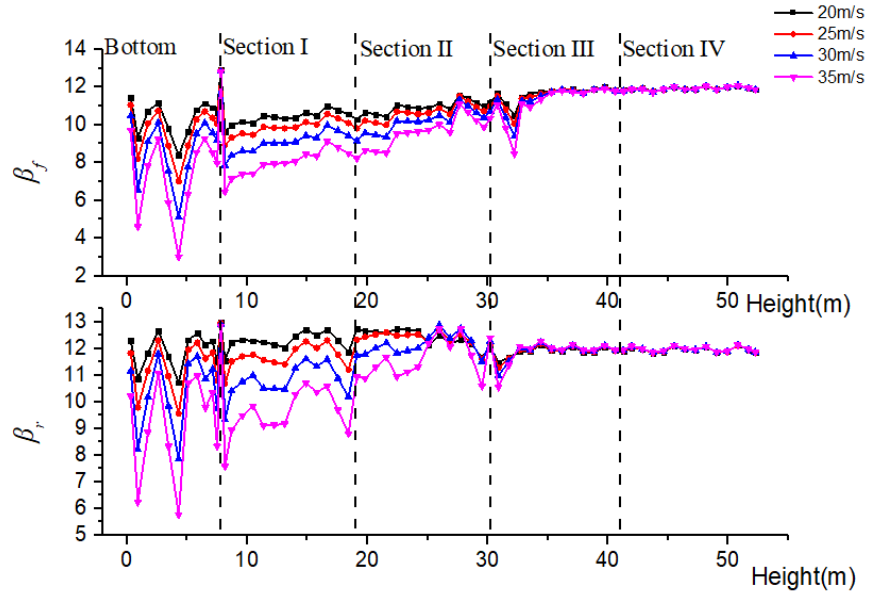
Figure 10. Variation curve of column reliability index along with height under different wind speeds.